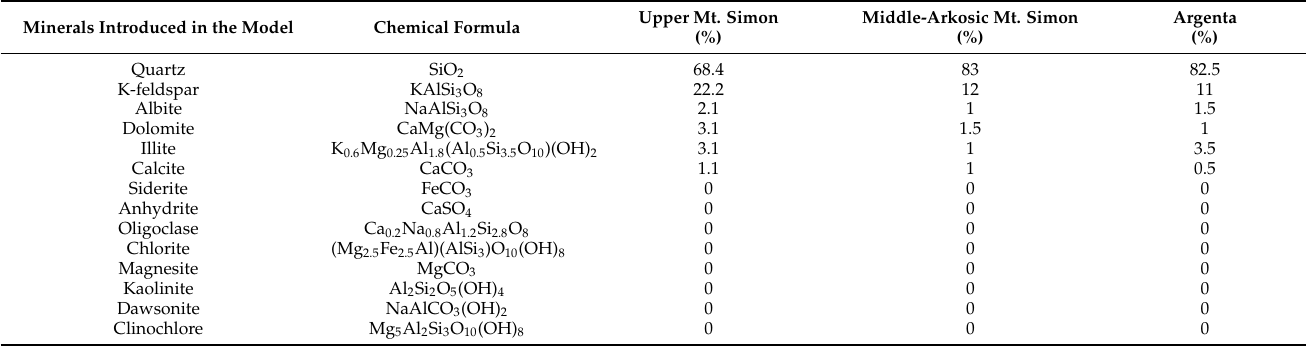
Table 3. Initial mineral volume fractions a and possible mineral phases used in the simulations.